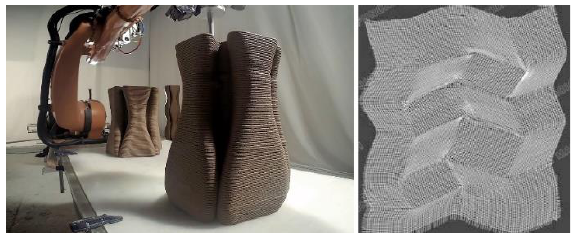
Figure 5. A robotic 3D print fabrication at IAAC (IAAC, n.d.) and a material study at Bauhaus (Albers,